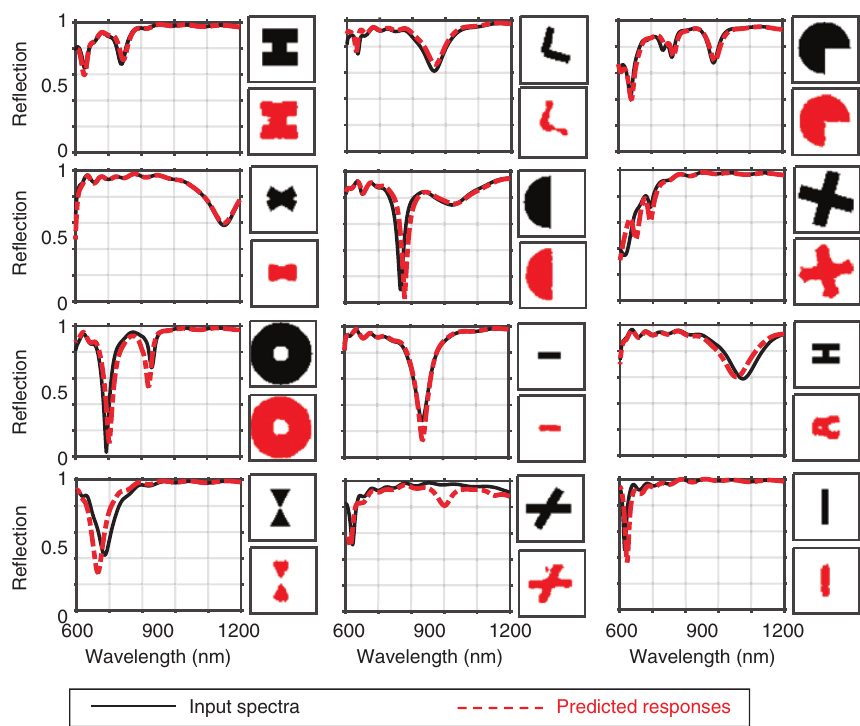
Figure 3: Twelve examples of cDCGAN-suggested images and their simulation results. Each panel is composed of reflection spectra and their corresponding structural cross-sectional images. The upper-right structural images are the target designs (black), and the lower-right images are the suggested images by cDCGAN (red). The left spectra show the desired input spectra (black solid lines) that we fed into the network and the predicted responses obtained from the suggested designs (red dotted lines).